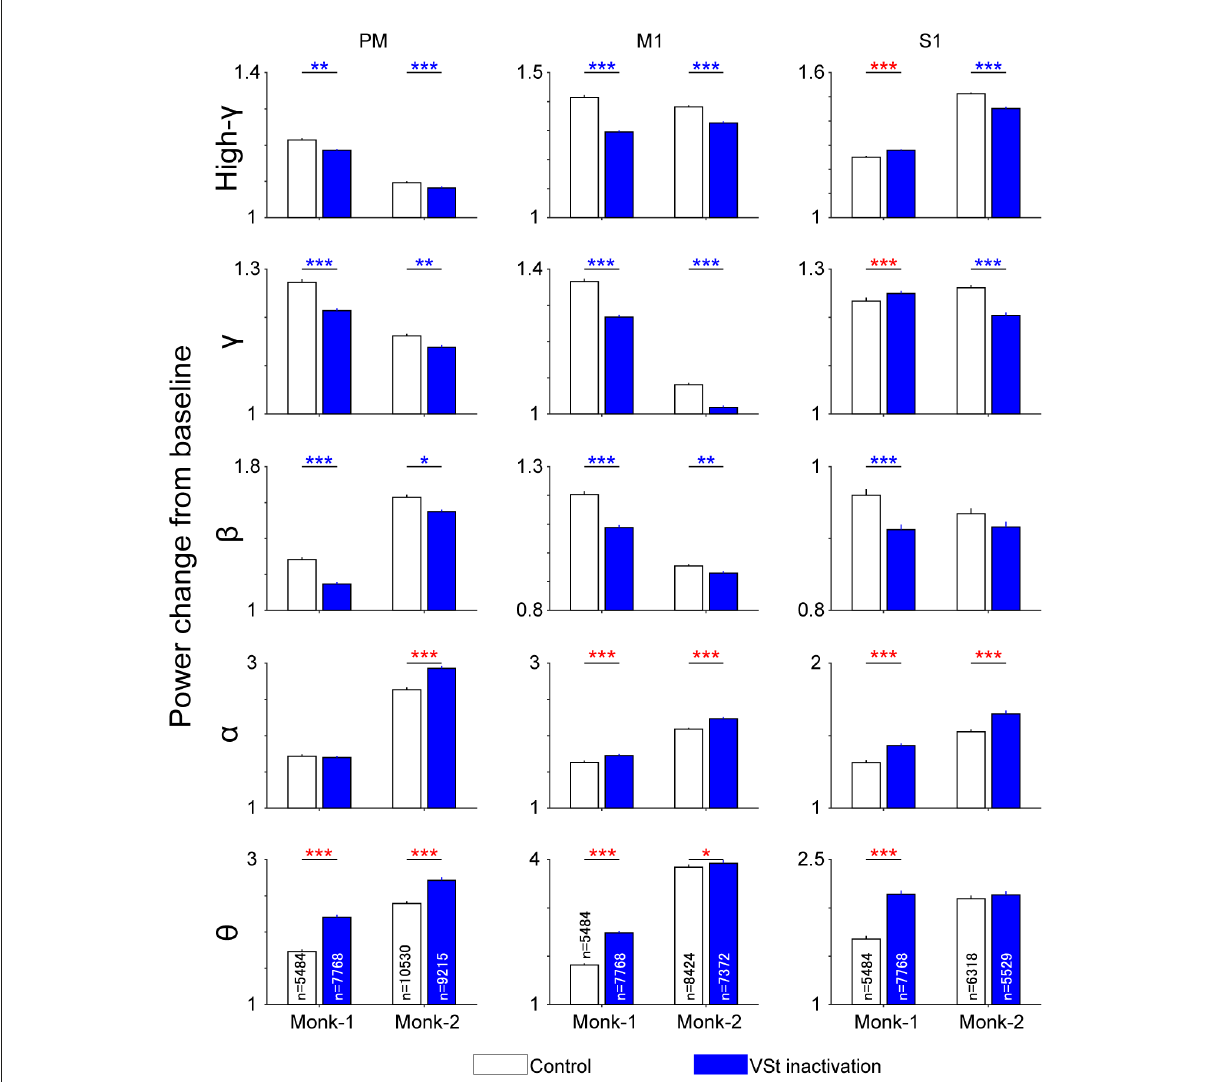
FIGURE4 Population data of movement-related power change in the SMC. Power change around the go cue (Monk-1, − 0.5 s to 0.5 s; Monk-2, 0 s to 1 s) from baseline were compared between control and VSt inactivation trials in each monkey. The frequency of interest was classified into the following five frequency bands, θ (5–7 Hz), α (8–14 Hz), β (15–30 Hz), γ (31–70 Hz), and high- γ (71–120 Hz). ‘n’ in bar graph indicates the number of trials × the number of channels in each area. Trials were pooled across sessions and targets and recording areas. Data are shown by the mean and standard error of the mean. Wilcoxon-signed rank test (control vs. VSt inactivation) was conducted for each panel. Blue asterisks indicate a significant decrease in VSt inactivation trials while red ones indicate an increase. * P < 0.05, ** P < 0.01, *** P < 0.001. P -values are displayed